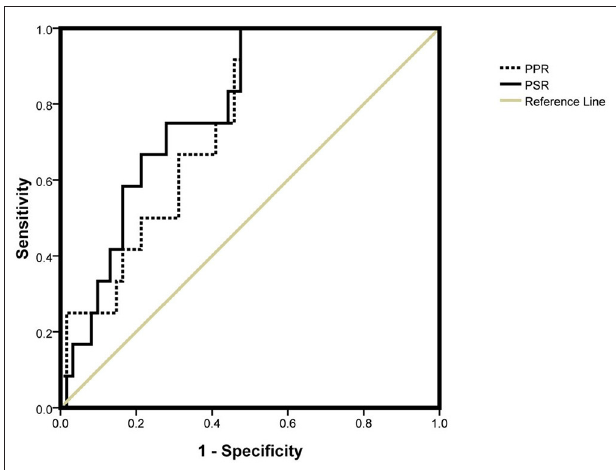
FIGURE 2 | AUC of the PPR and PSR. PPR, platelet-to-portal vein width ratio; PSR, platelet-to-spleen thickness ratio.